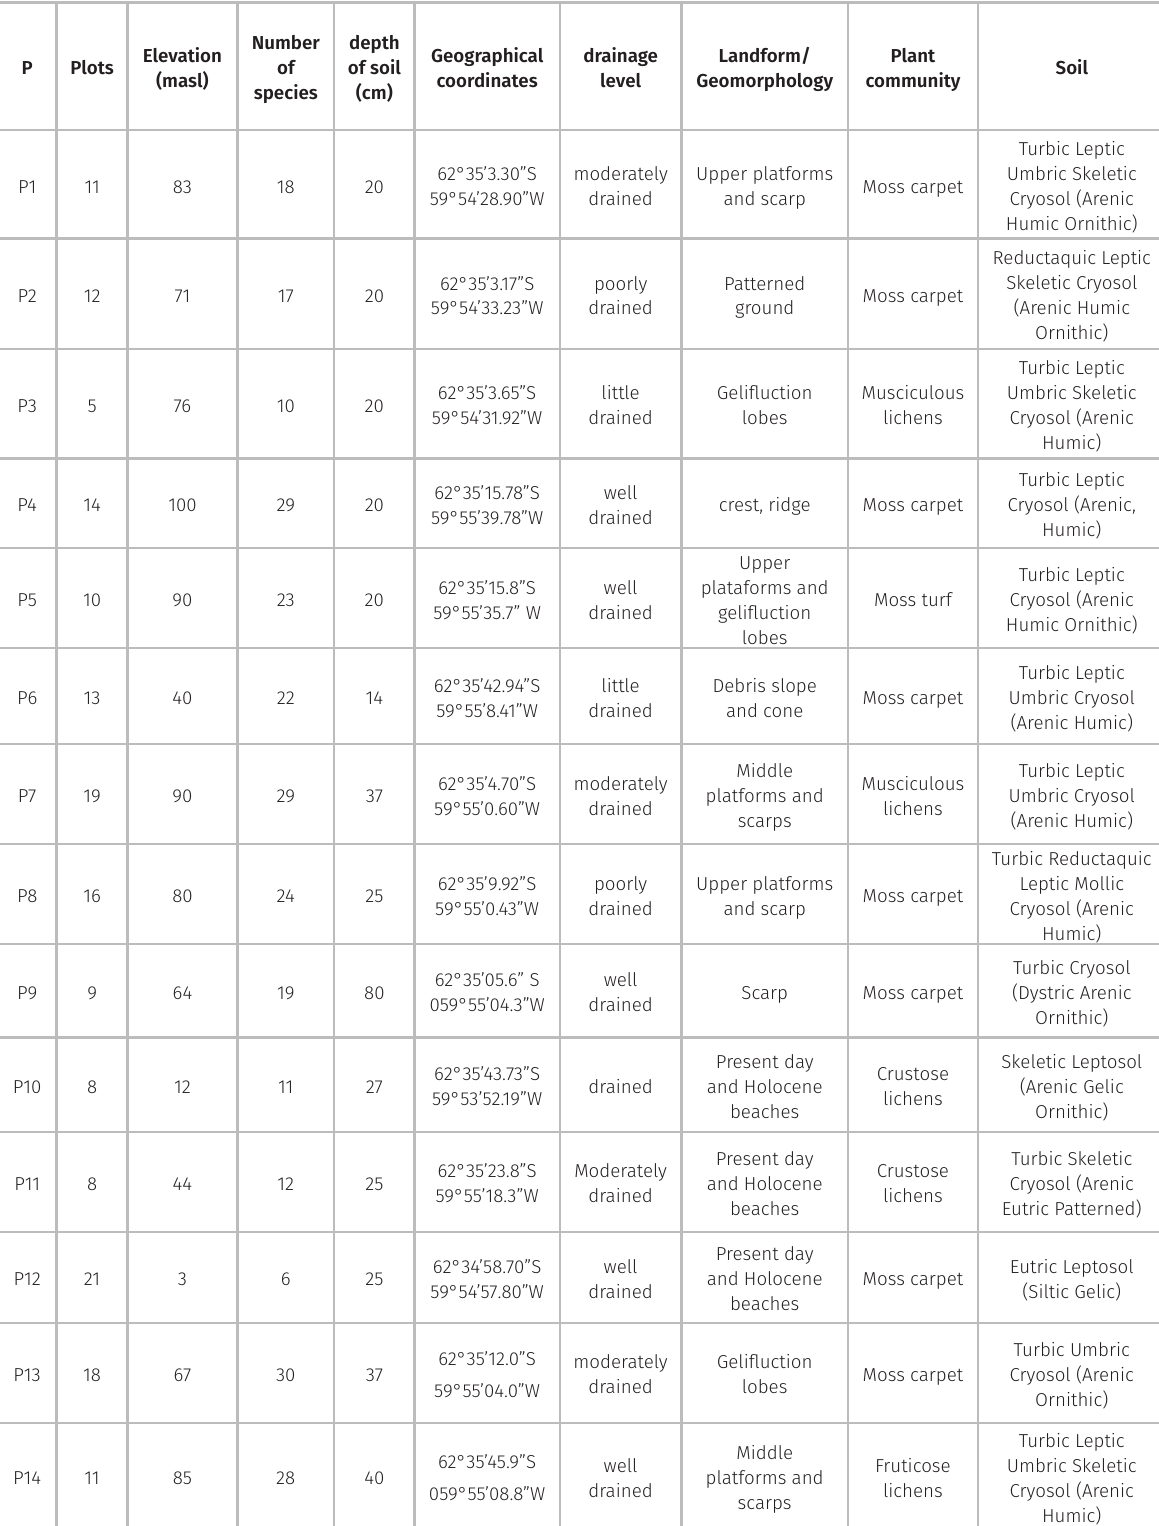
Table I. Description of the 14 sampling pedoenvironments (P).